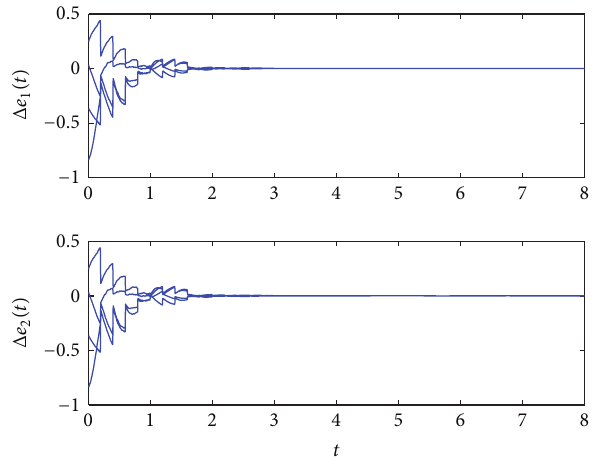
Figure 6: Observer estimated states jumps at the impulse times.